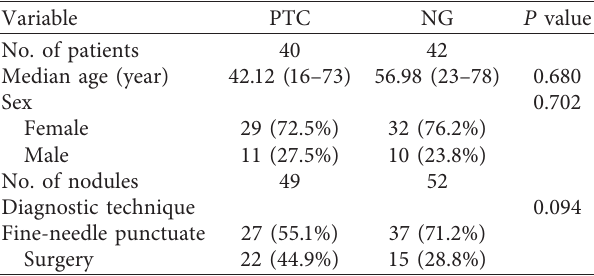
Figure 1: The patient selection and procedural flowchart. Table 1: Clinical characteristics of thyroid